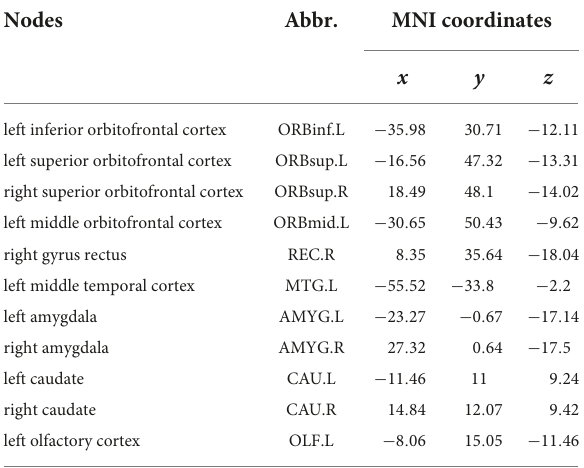
TABLE 2 Nodes showing significant difference in functional connectivity (FC) analysis between HC and KOA groups’ patients ( P < 0.05, FDR